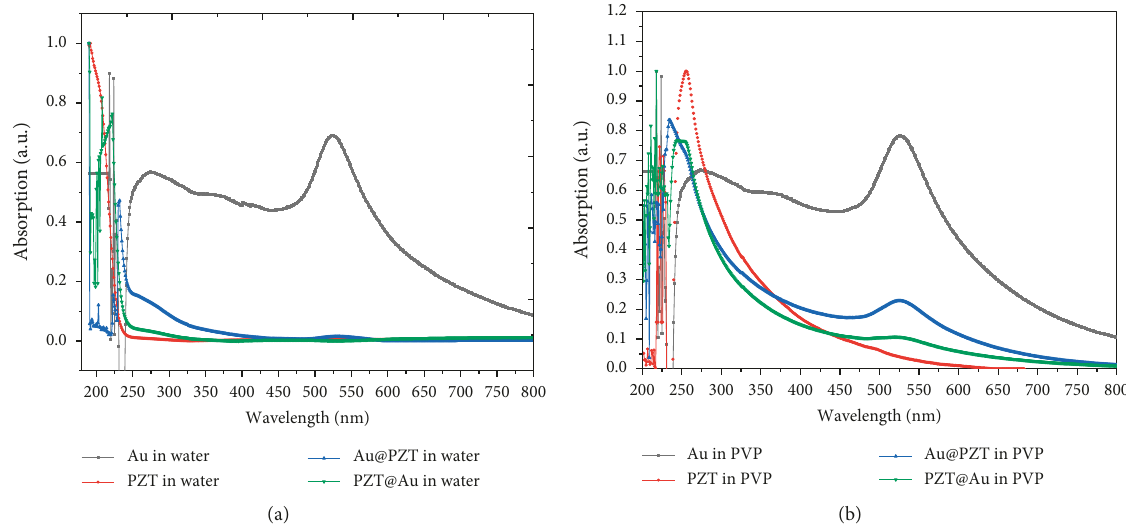
Au in water PZT in water Figure 4: Absorption spectra of core-shell NPs: (a) in water solvent and (b) in PVP solvent.